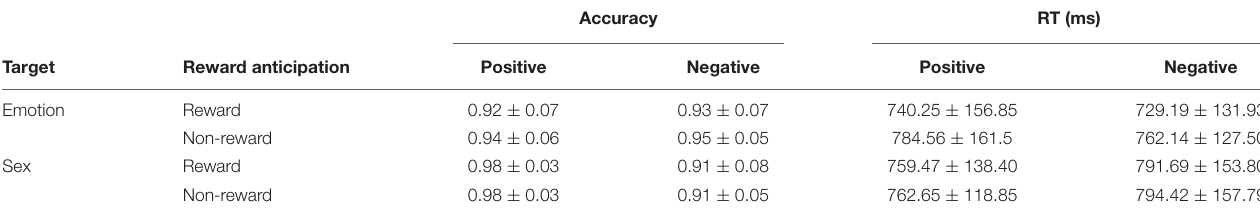
TABLE 3 | Descriptive statistics of accuracy and RT under different conditions ( M ±